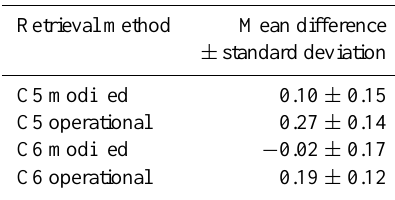
Figure 4. (a) Correlation between slope a 0 . 47 / 0 . 65 used for the AOD retrieval and the resulting AOD at 0.55µm for Zhongshan for the C5 and the C6 algorithm applied for measurements on 1 Decem- ber 2009. (b) Relative frequency distribution of retrieved AOD for Zhongshan for the modified C5 and C6 code. The corresponding AOD of the unchanged operational retrievals is shown as vertical lines. Table 3. Mean value and standard deviation of differences between AOD(MODIS) and